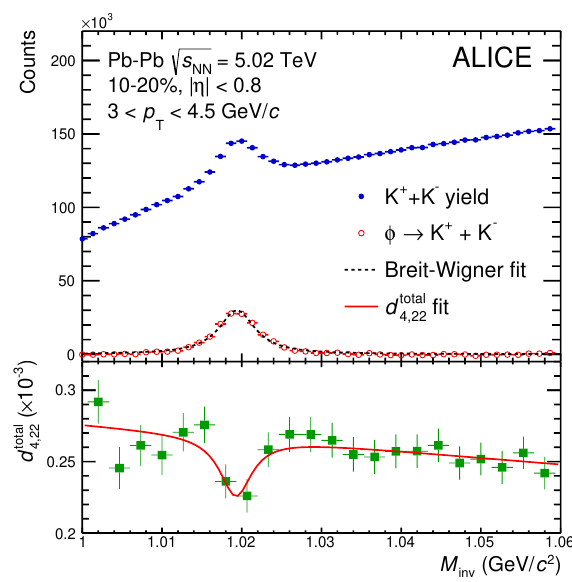
Figure 1 . Reconstruction and d 4 ; 22 measurement of (cid:30) -mesons. Upper panel: extraction of N sig and N bkg by (cid:12)tting the invariant mass ( M inv ) distribution for (cid:30) -meson candidates from pairs of kaons with opposite charges for 3 < p T < 4 : 5 GeV =c and the 10{20% centrality interval, lower panel: extraction of d sig by (cid:12)tting eq. (4.7) to the invariant mass dependence of d total 4 ; 22